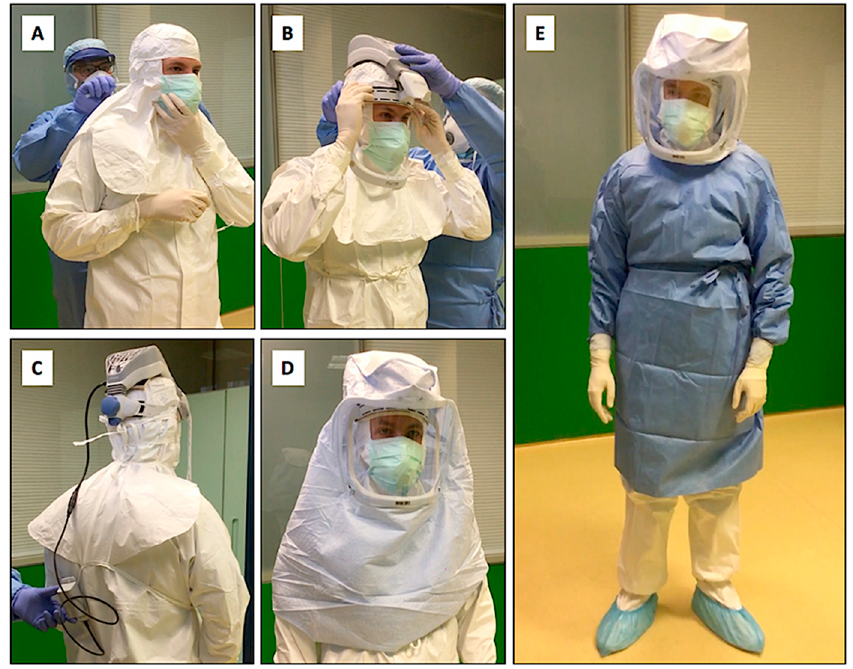
Figure 1. Enhanced droplet/airborne Personal Protective Equipment incorporating use of Powered Air Purifying Respirator (PAPR) for ECMO positioning. The healthcare staff wear impermeable disposable coveralls with impermeable overshoes and special waterproof hoods and surgical masks, which are worn over the headgear and FFP2-3 mask ( A ). The PAPR system is worn over the hood of the suit and PAPR blower unit, made by plastic helmet ( B ) with battery on belt ( C ) and covered by a hood with a filter material ( D ). Completed PPE includes a sterile gown and sterile gloves ( E ). Table 1. Steps to put on/take off personal protective equipment (PPE) for ECMO procedures in patients with COVID-19. Context